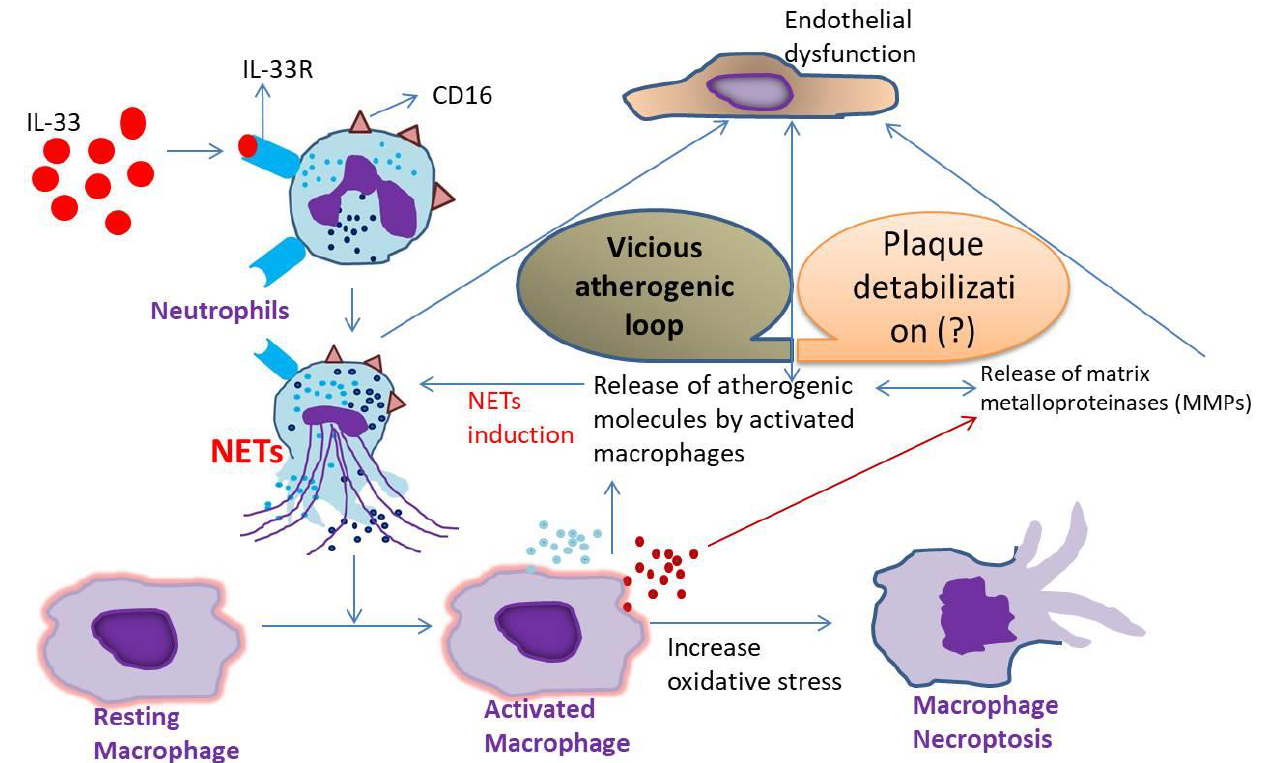
Figure 7. Schematic representation of the mechanism of action of IL-33 in triggering NET formation, macrophage activation and necroptosis, augmenting the release of atherogenic factors and matrix metalloproteinases (MMPs), and increased oxidative stress, collectively leading to endothelial dys- function and the exacerbation of the disease by plaque destabilization (? = not clearly defined) (refer to the conclusion section for